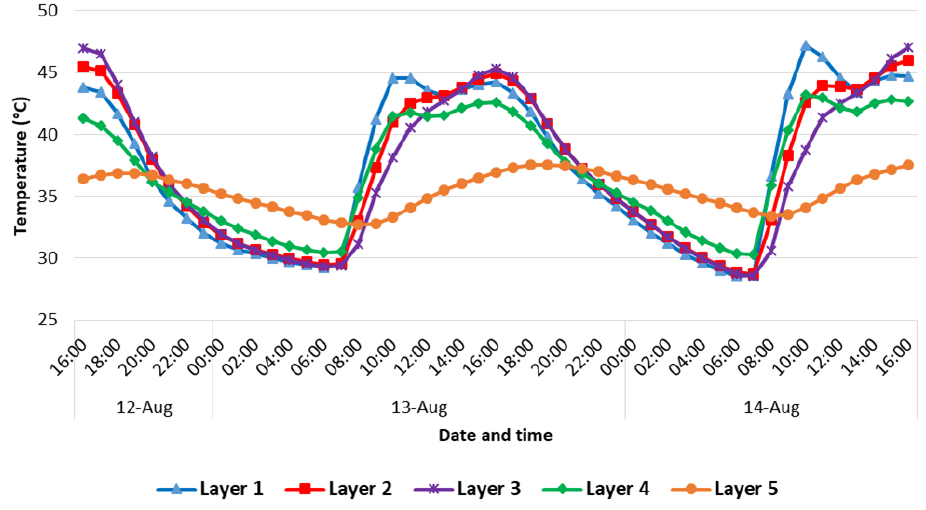
Figure 14. Radiant temperature variations in the mask wall layers.